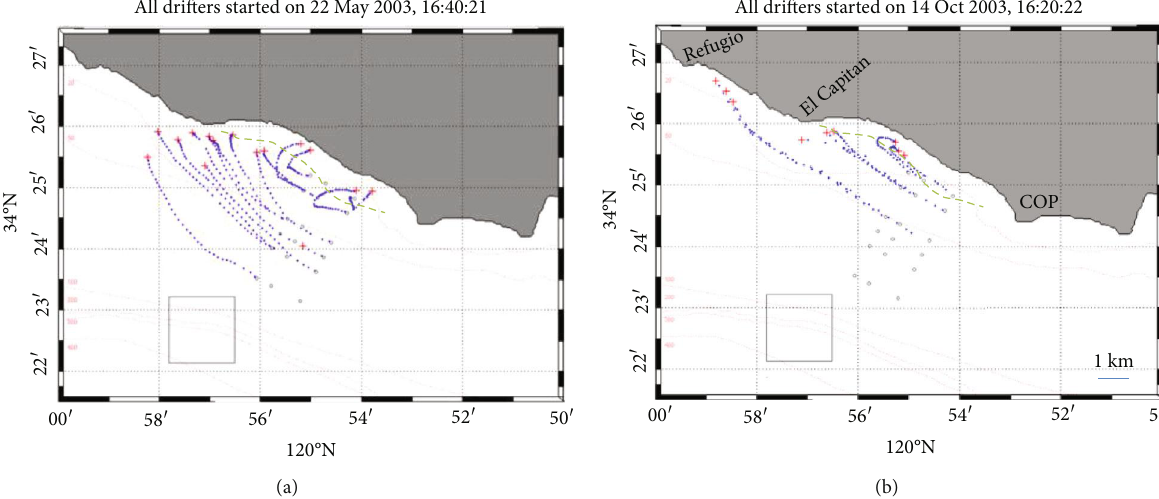
Figure 26: Drifter data for Santa Barbara Channel, west of Coal Oil Point (COP). Dashed green line shows where o ff shore currents shift to an inshore countercurrent. Box shows CODAR coverage. Adapted from Ohlmann